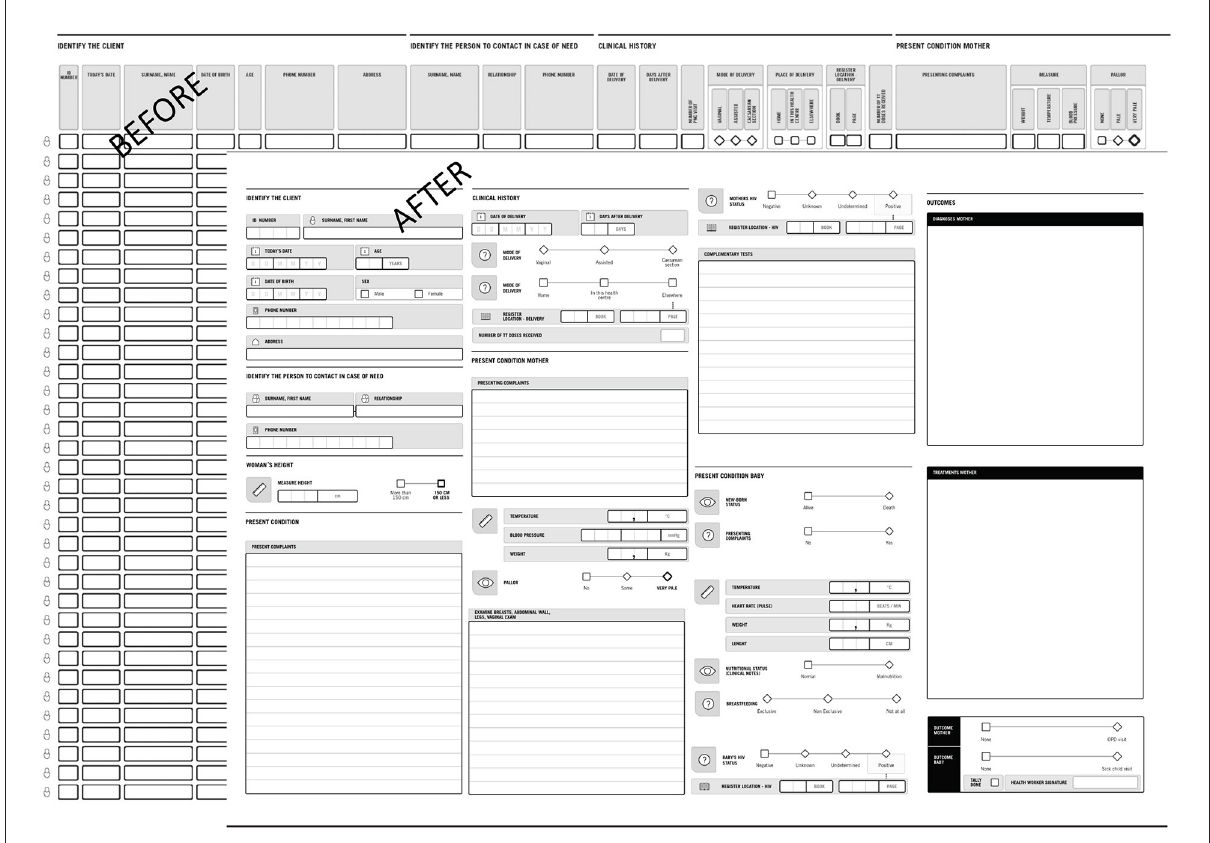
FIGURE3 PHISICC postnatal care register, before and after the series of co-design